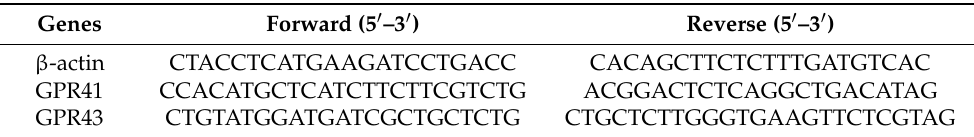
Table 2. Primer sequences used for RT-PCR.